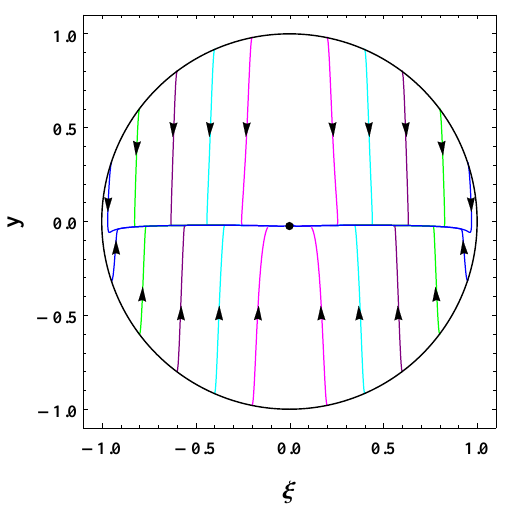
Figure 2. The phase portrait for the potential (3) with n = 5/3. The trajectories with arrows exhibit the time evolution from the bouncing boundary to the origin. We chose m = 0.2 m pl for better